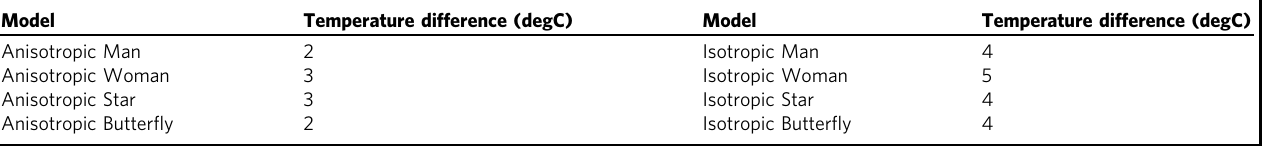
Table 1 The temperature difference between A and B in Fig.